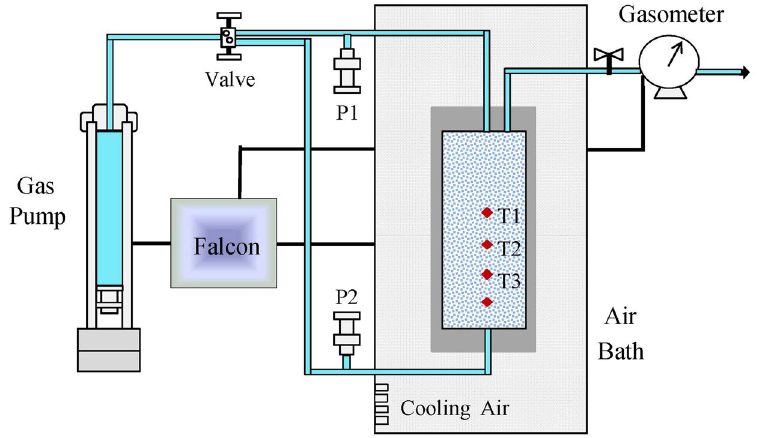
Figure 9. Schematic diagram of the experimental